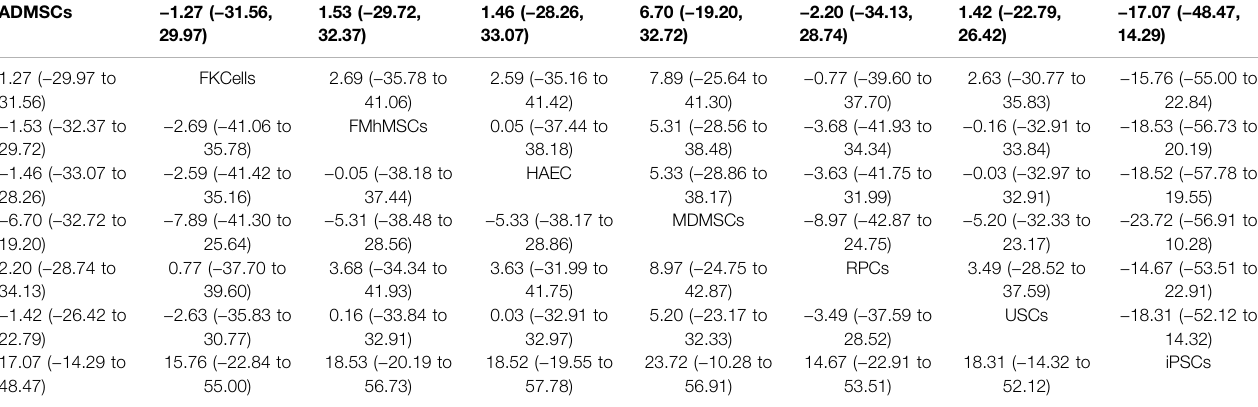
TABLE 18 | Network Meta-analysis results of apoptosis of resident cells in stem cell groups in early stage after administration.